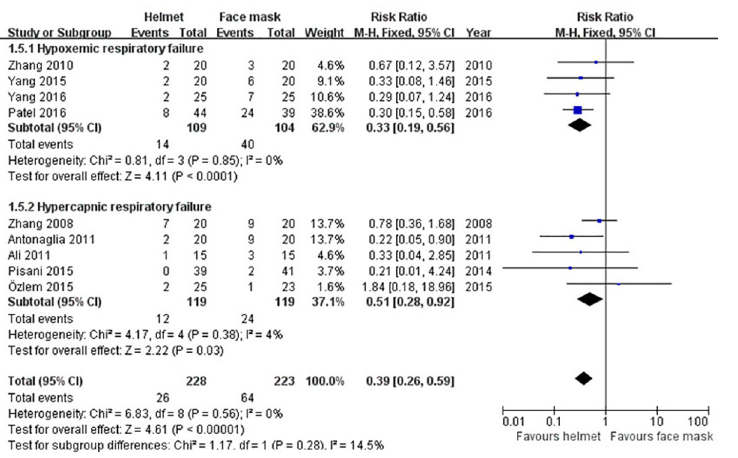
Fig 8. Forest plot of endotracheal